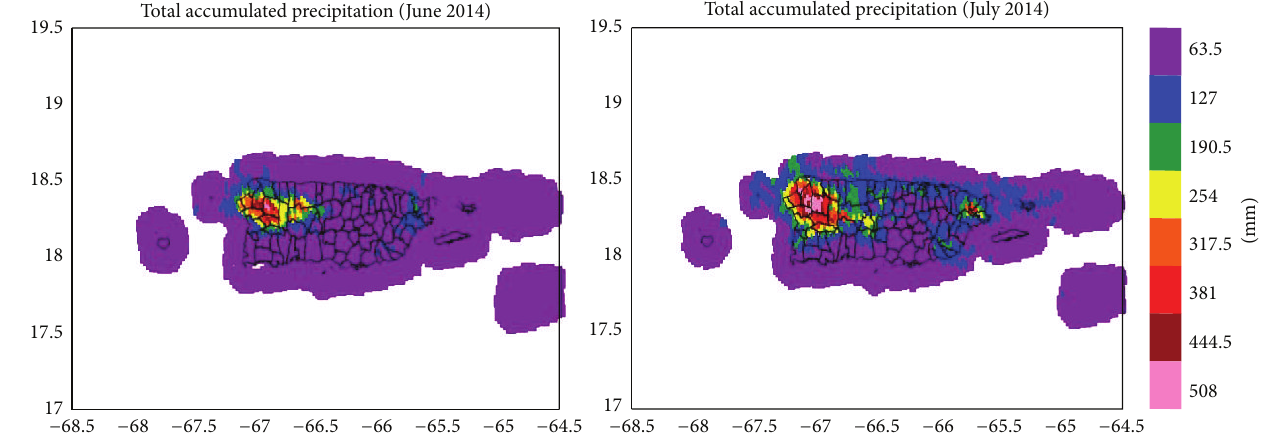
Figure 2: Total accumulated precipitation over Puerto Rico for June and July